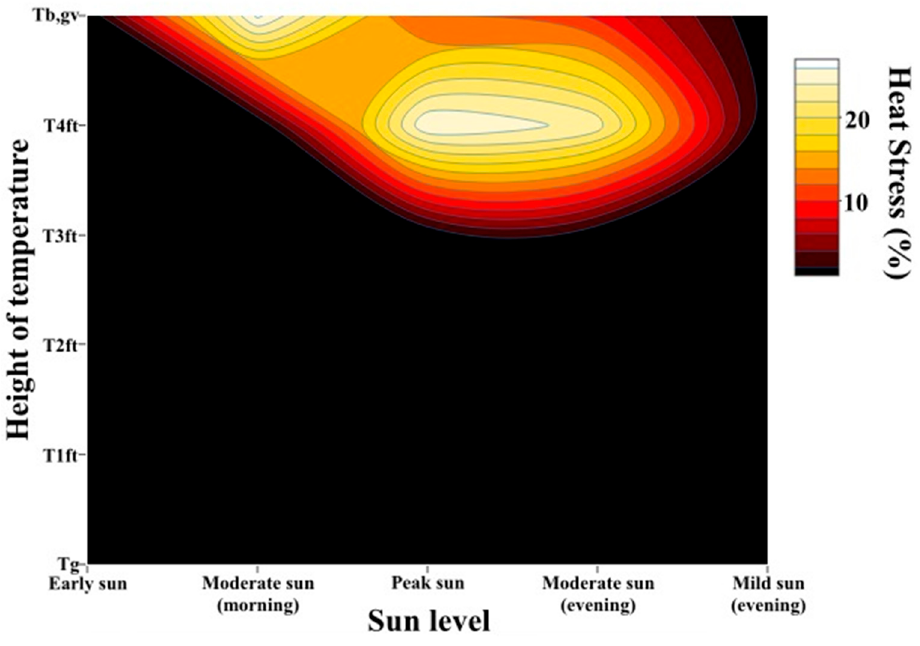
Figure 8. Heat stress occurrences (%) at five sampling hours.